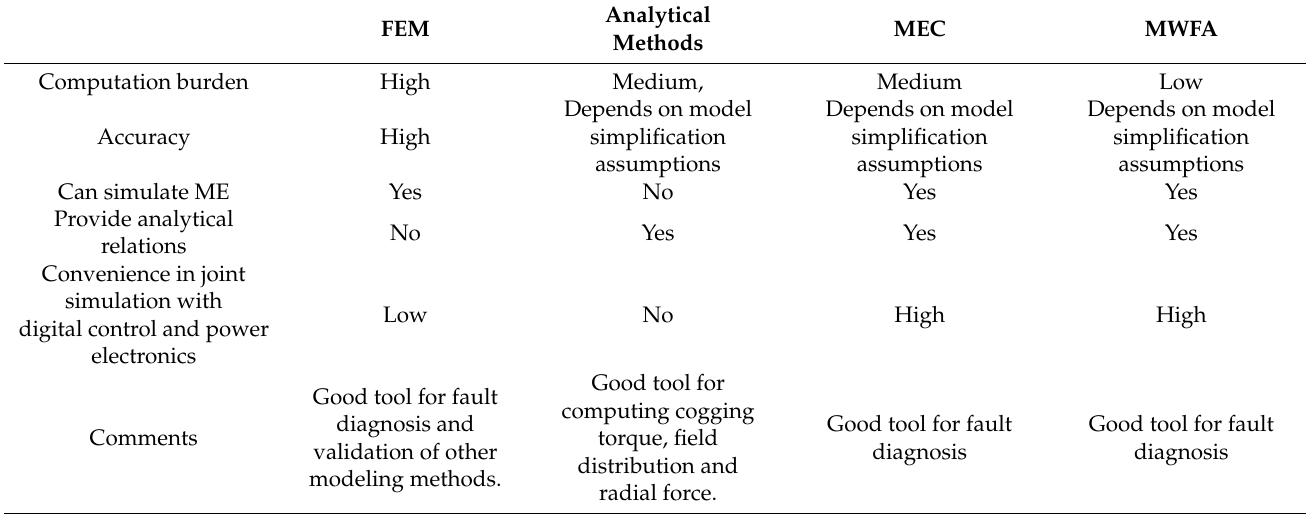
Table 1. Qualitative comparison between modeling methods for eccentricity